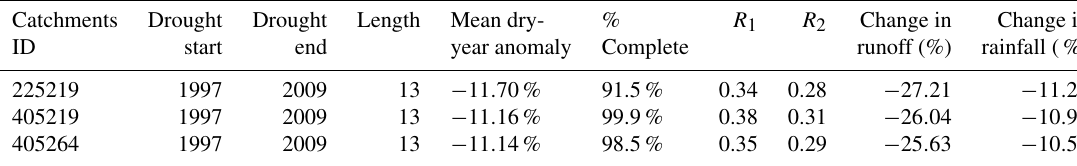
Table 3. Drought identification results for the catchments. Catchments